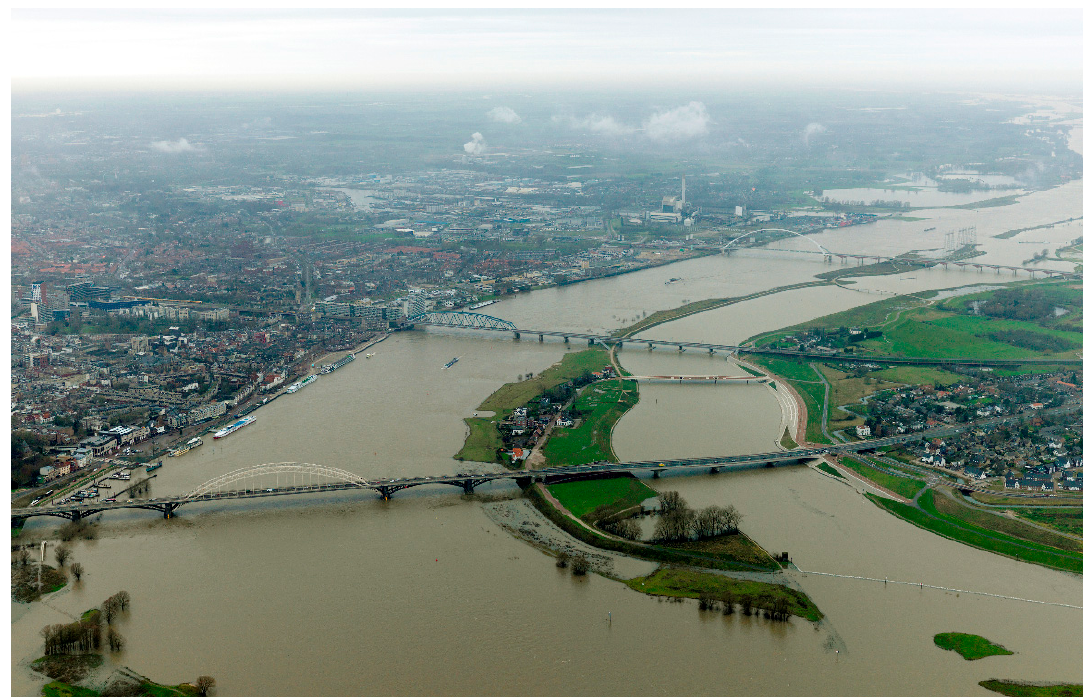
Figure 10. Bypass in the Waal river at Nijmegen (copyright RWS).